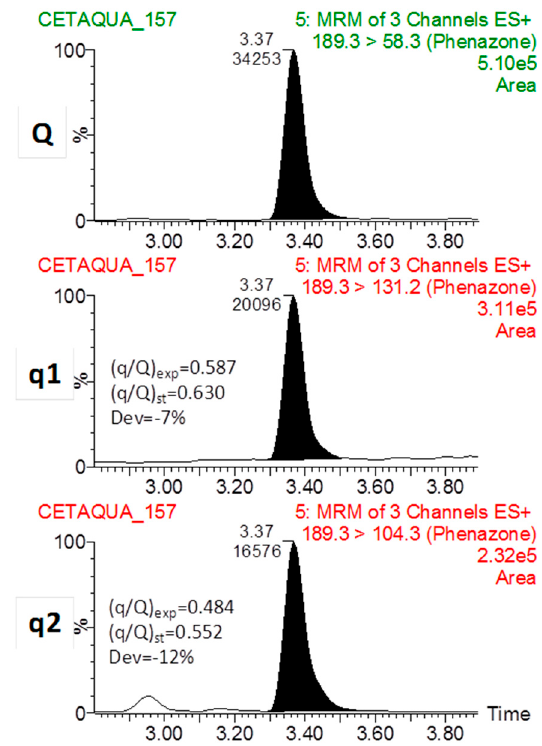
Figure 4. UHPLC-MS/MS chromatograms detected for a positive of phenazone in an EWW (effluent of the wastewater treatment plant) sample analyzed. (Q) corresponds to the transition used for quantification, and (q1) and (q2) to those used for confirmation. (q/Q)exp: in the sample; (q/Q)st in the reference standard; Dev: deviation (%).